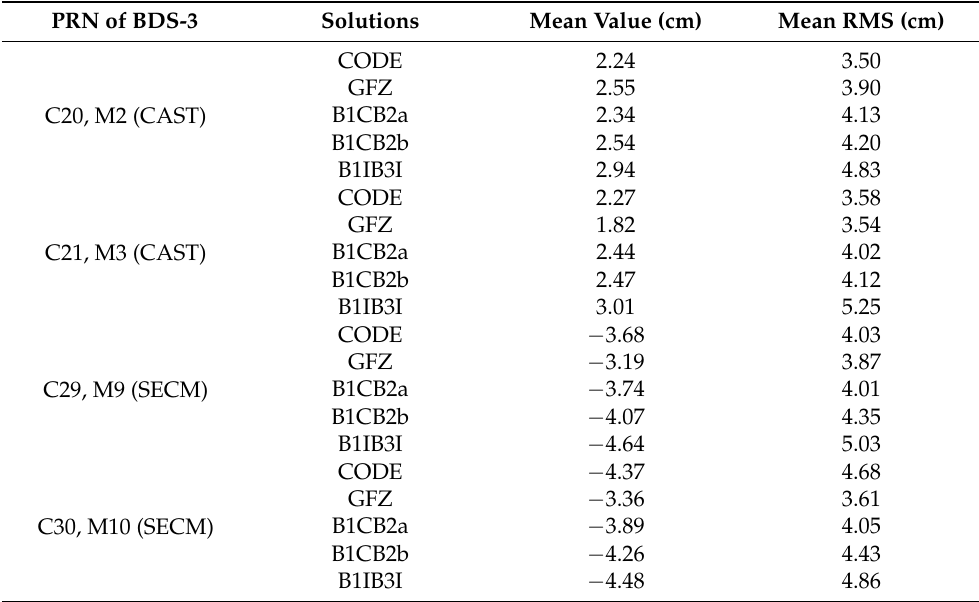
Table 5. Mean value and mean RMS of SLR residuals of BDS-3